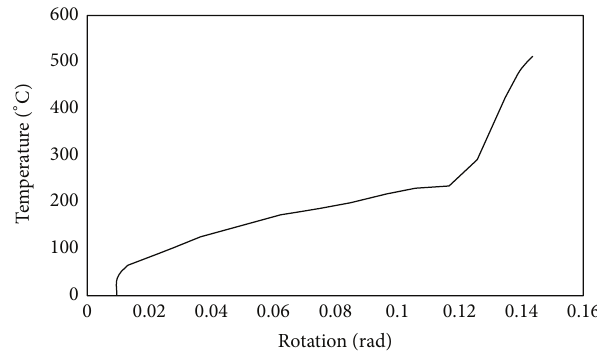
Figure 19: The temperature graph: the rotation of connection with the end plate.